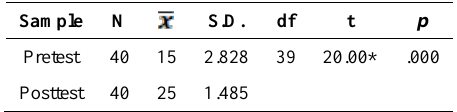
Table 3. Student pre-test and post-test testing results